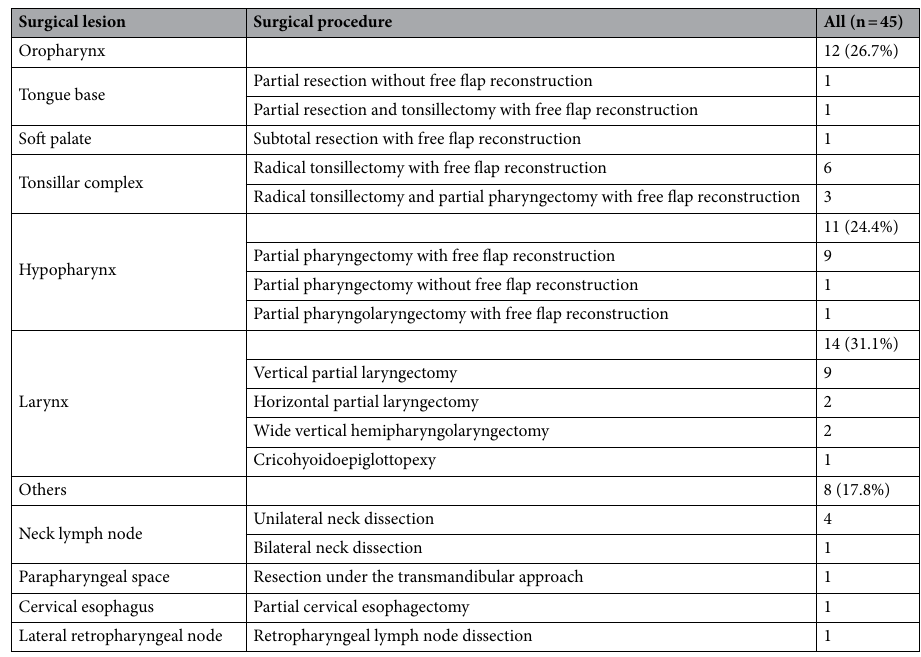
Table 2. Surgical lesions and surgical procedures.